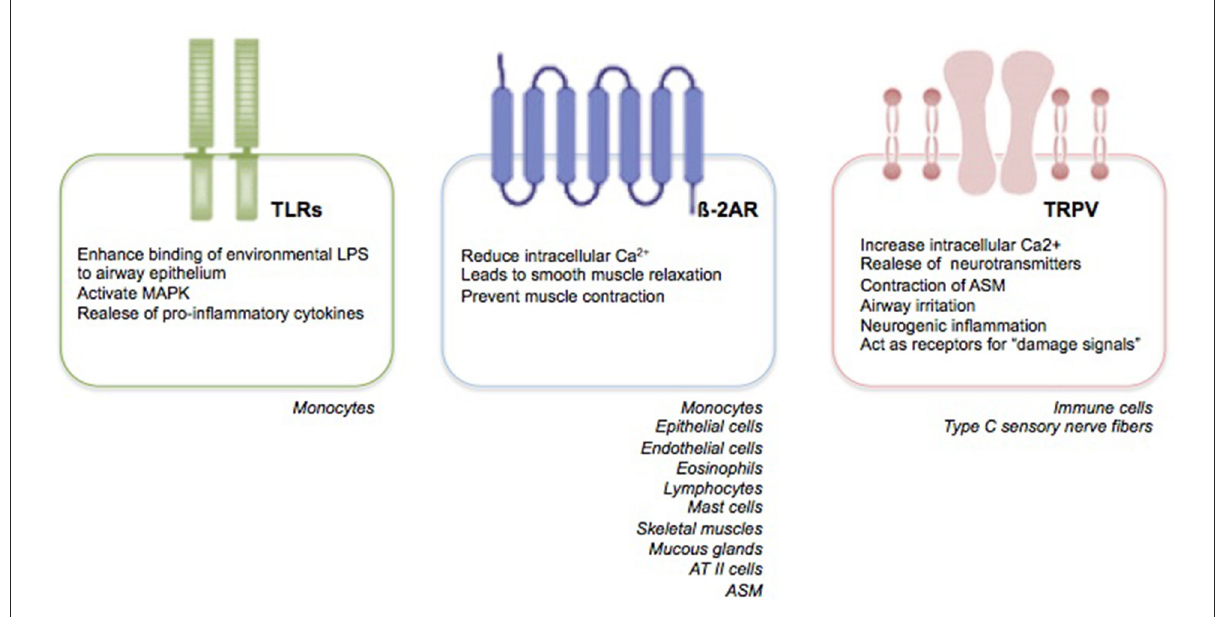
FIGURE1 RSV receptors. Expression and function of RSV